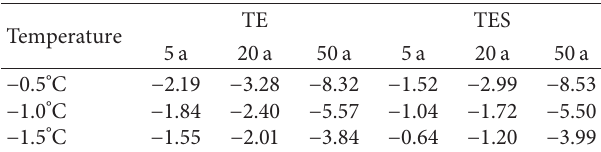
Table 5: Variation of the table permafrost beneath the TE and TES under different mean annual ground temperatures (unit: